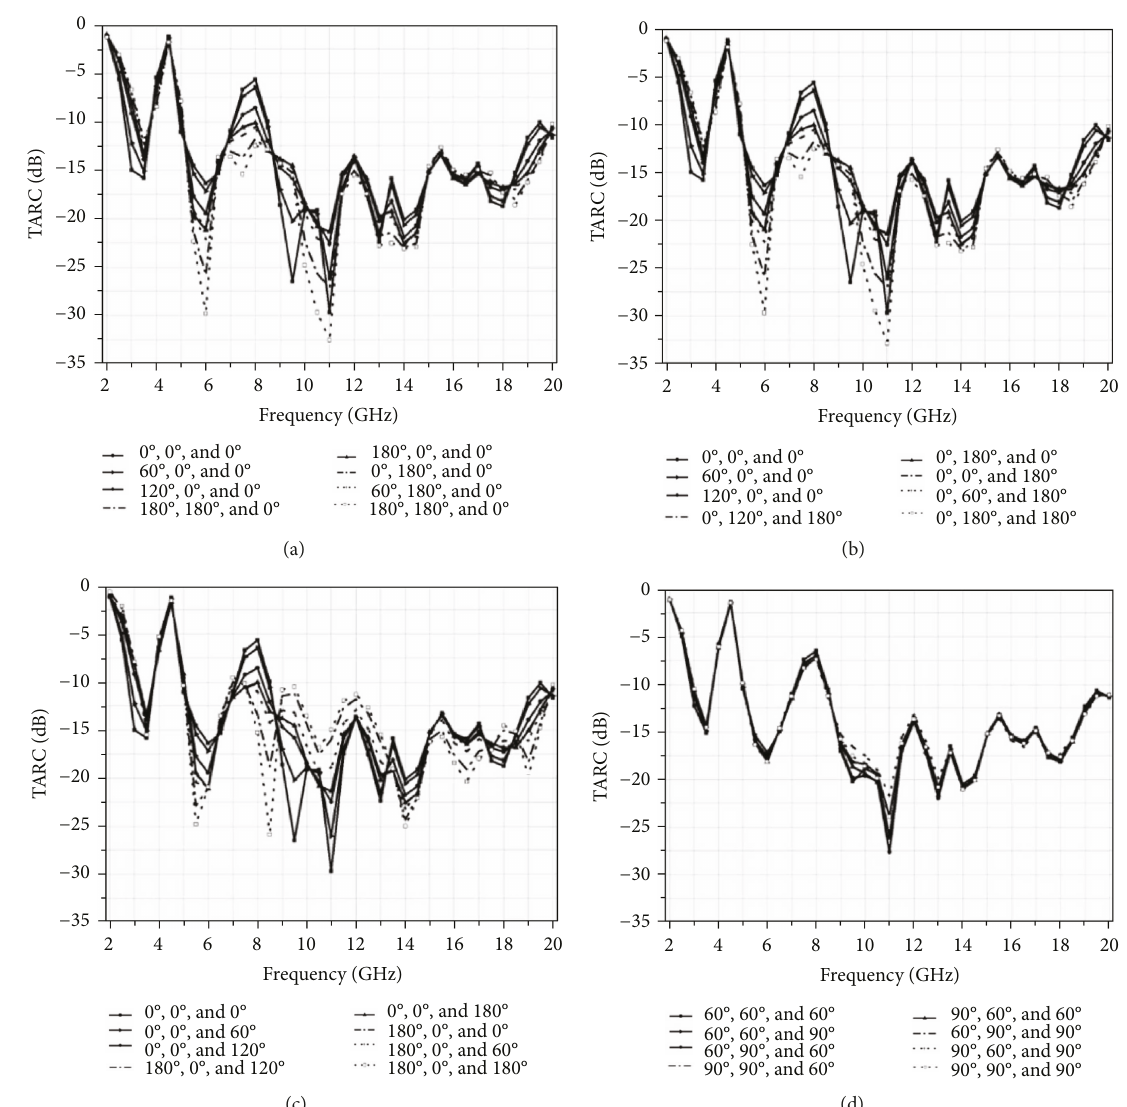
Figure 11: TRAC curves for the proposed MIMO antenna with di ff erent phase combinations between the four elements: (a) elements 1 and 4 are in phase; (b) elements 1 and 2 are in phase; (c) elements 1 and 3 are in phase; (4) all elements are out of